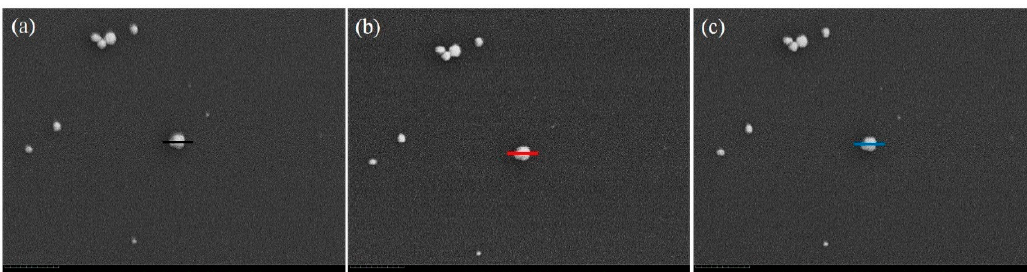
Figure 10. BSE images of the mixed gold particles and polystyrene particles sample taken at 10 keV with ( a ) MA BSE detector, ( b ) MA p-n BSE detector and ( c ) the MA-Al detector.